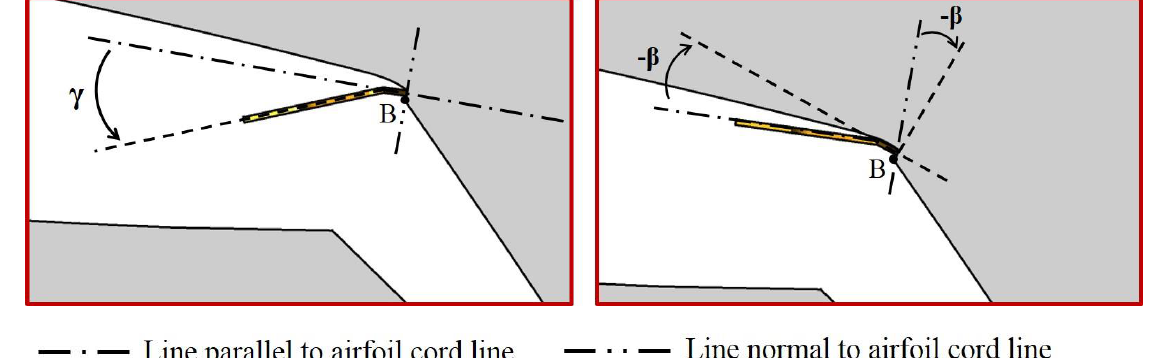
Figure 4. Installation conditions of fluidic oscillators.